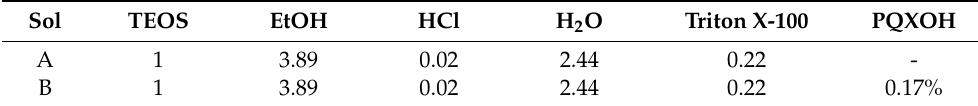
Table 1. Molar ratio of the components of the SiO 2